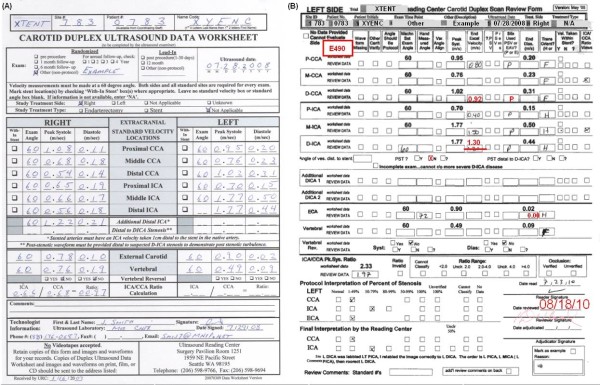
Duplex Data Worksheet and Review Form. A. The Duplex Data Worksheet is submitted to the UWURC by the sonographer plus copies of the images to document the duplex Doppler data. B. UWURC Review Form with keyed data and reader/reviewer entries. Black printed entries are keyed from the worksheet submitted from the field center. Hand written entries by the reader were transcribed or measured from the image provided by the field centers. Typed entries in red by the reviewer mark additional changes based on the images.